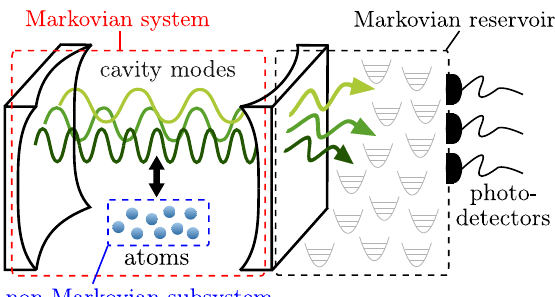
FIG. 1. Schematic setup, showing the gain of information about a many-body system of atoms in a multimode cavity, through detection of light leaking out of the cavity. While the combined cavity-atom system (red box) can be Markovian, it is a highly complex system with many modes. In the case of strong coupling between the atoms and the cavity, the reduced system of atoms (blue box) exhibits non-Markovian dynamics. Our formalism allows us to determine the information gained about this reduced system from the measurements, determin- ing the measurement-conditioned dynamics, and allowing for continuous